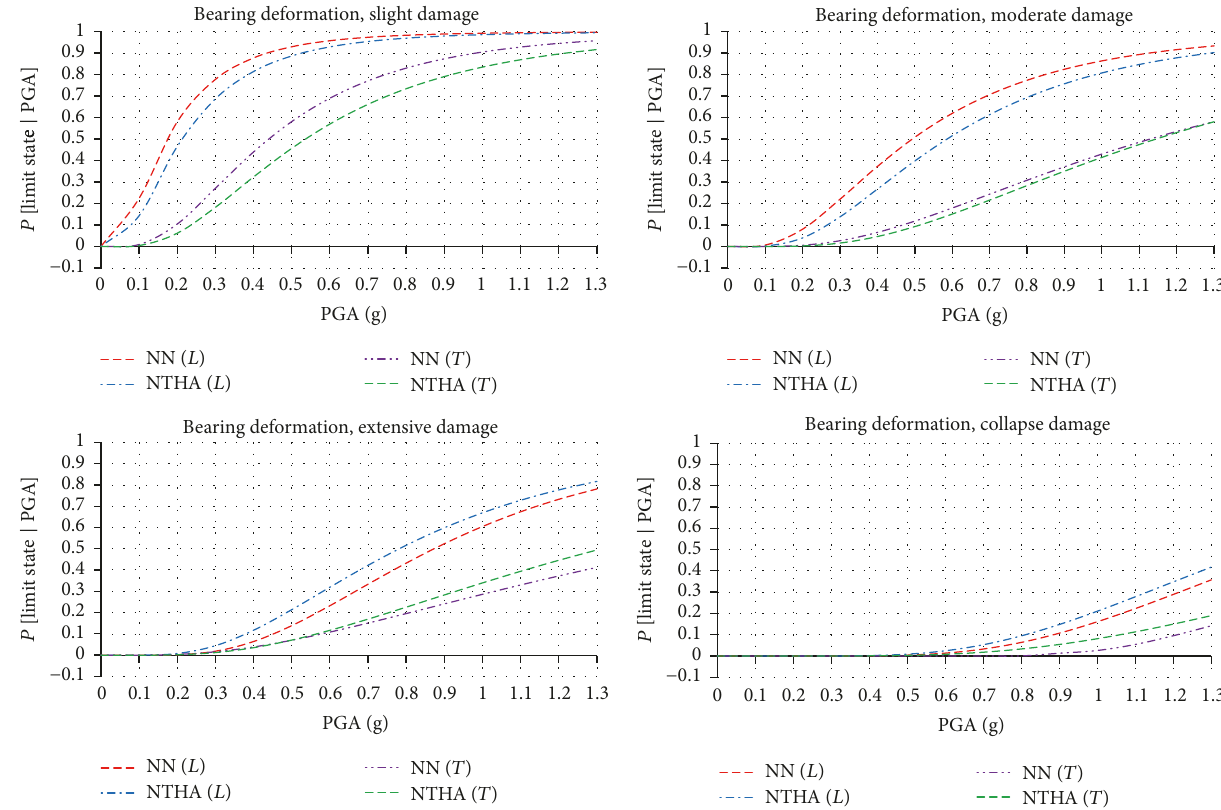
Figure 15: Comparison of the bearing fragility curves by NN (Approach 1) and NTHA methods.